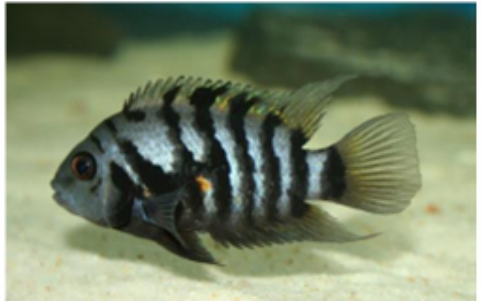
Figure 7. Convict Cichlids (Wikipedia,